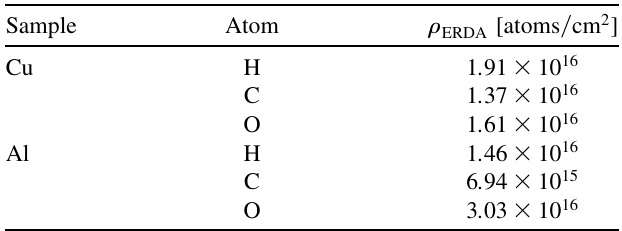
INFLUENCE OF FS-LASER DESORPTION ON TARGET . . TABLE I. Particle concentration (cid:3) on the surface of alu- ERDA minum and copper target foils of 20 (cid:1) m thickness summed over a measurement depth of (cid:5) 1 (cid:1) m . The ERDA measurements were performed by a high resolution magnetic spectrometer for the analyzation of hydrogen and by an ionization chamber for the analyzation of carbon and oxygen.